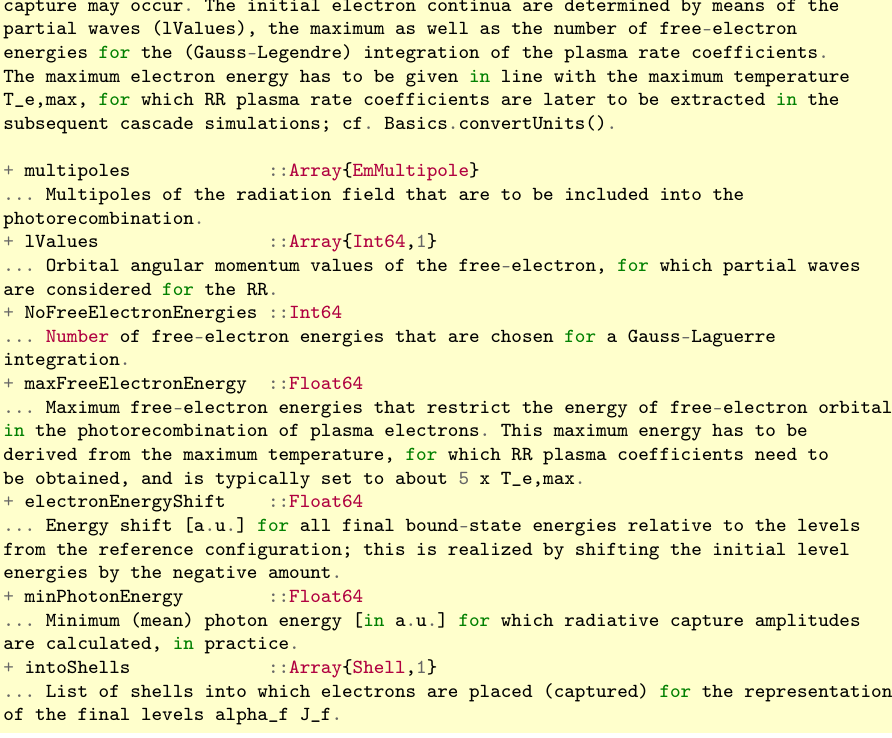
Figure 2. Definition of the data structure Cascade.RadiativeRecombinationScheme in J AC that helps perform the cascade computations in Section 3 below. It is one of the supported cascade schemes of a Cascade.Computation and enables the user to specify the multipole components of the radiation field in the photorecombination of the ion, the partial waves of the incoming free electrons, the discretization of the free-electron continuum, as well as the shells into which electrons are to be captured. See text for further